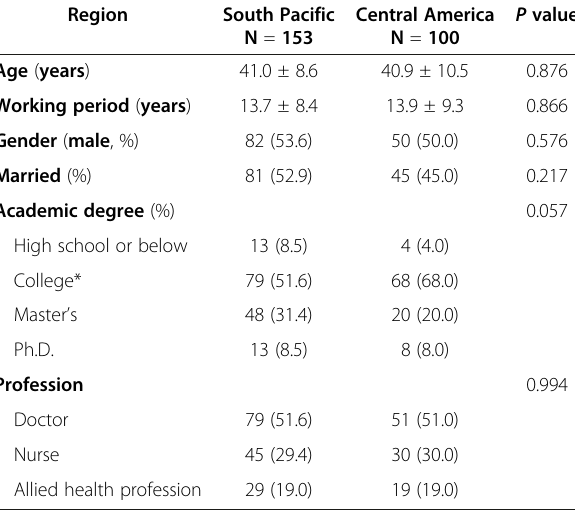
Table 4 Services provided by 46 STMMs to the South Pacific and 25 STMMs to Central America